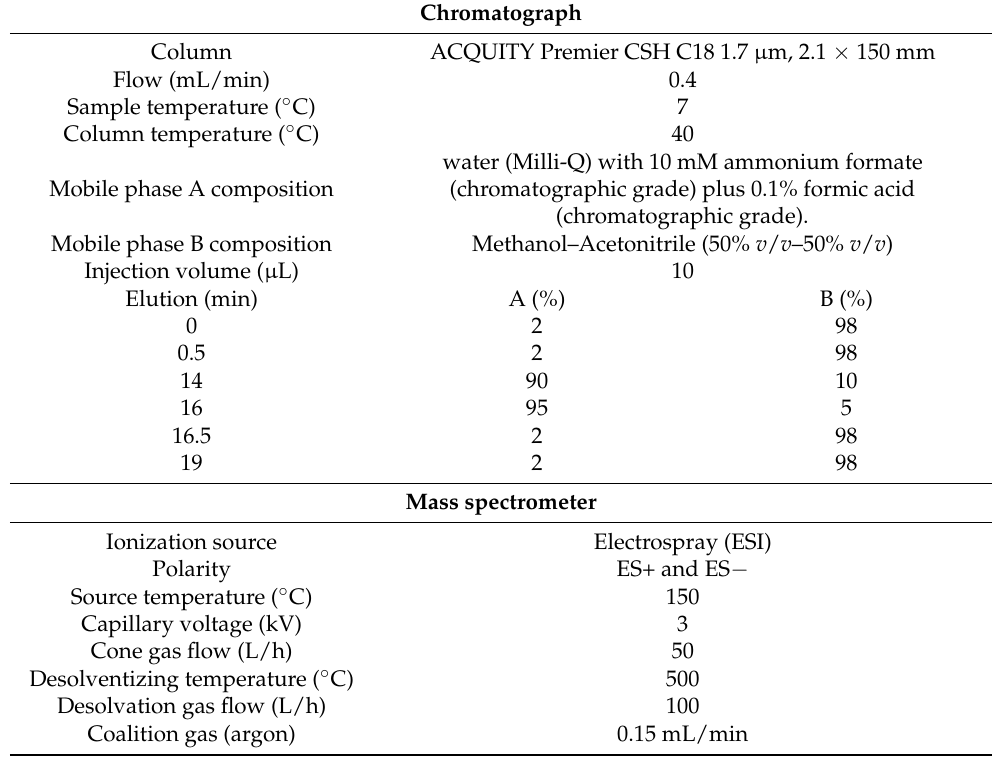
Table 3. Technical details of the operation of the liquid chromatograph–mass